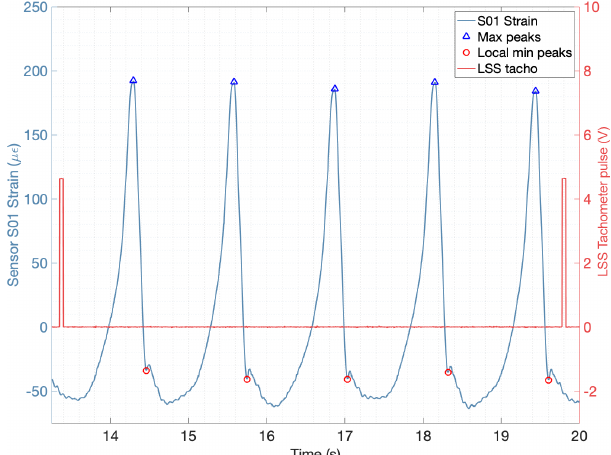
Figure 8. Peak-to-peak strain values of all detected gear mesh events of strain sensors S04, S17, and S53 vs. torque in the low- speed